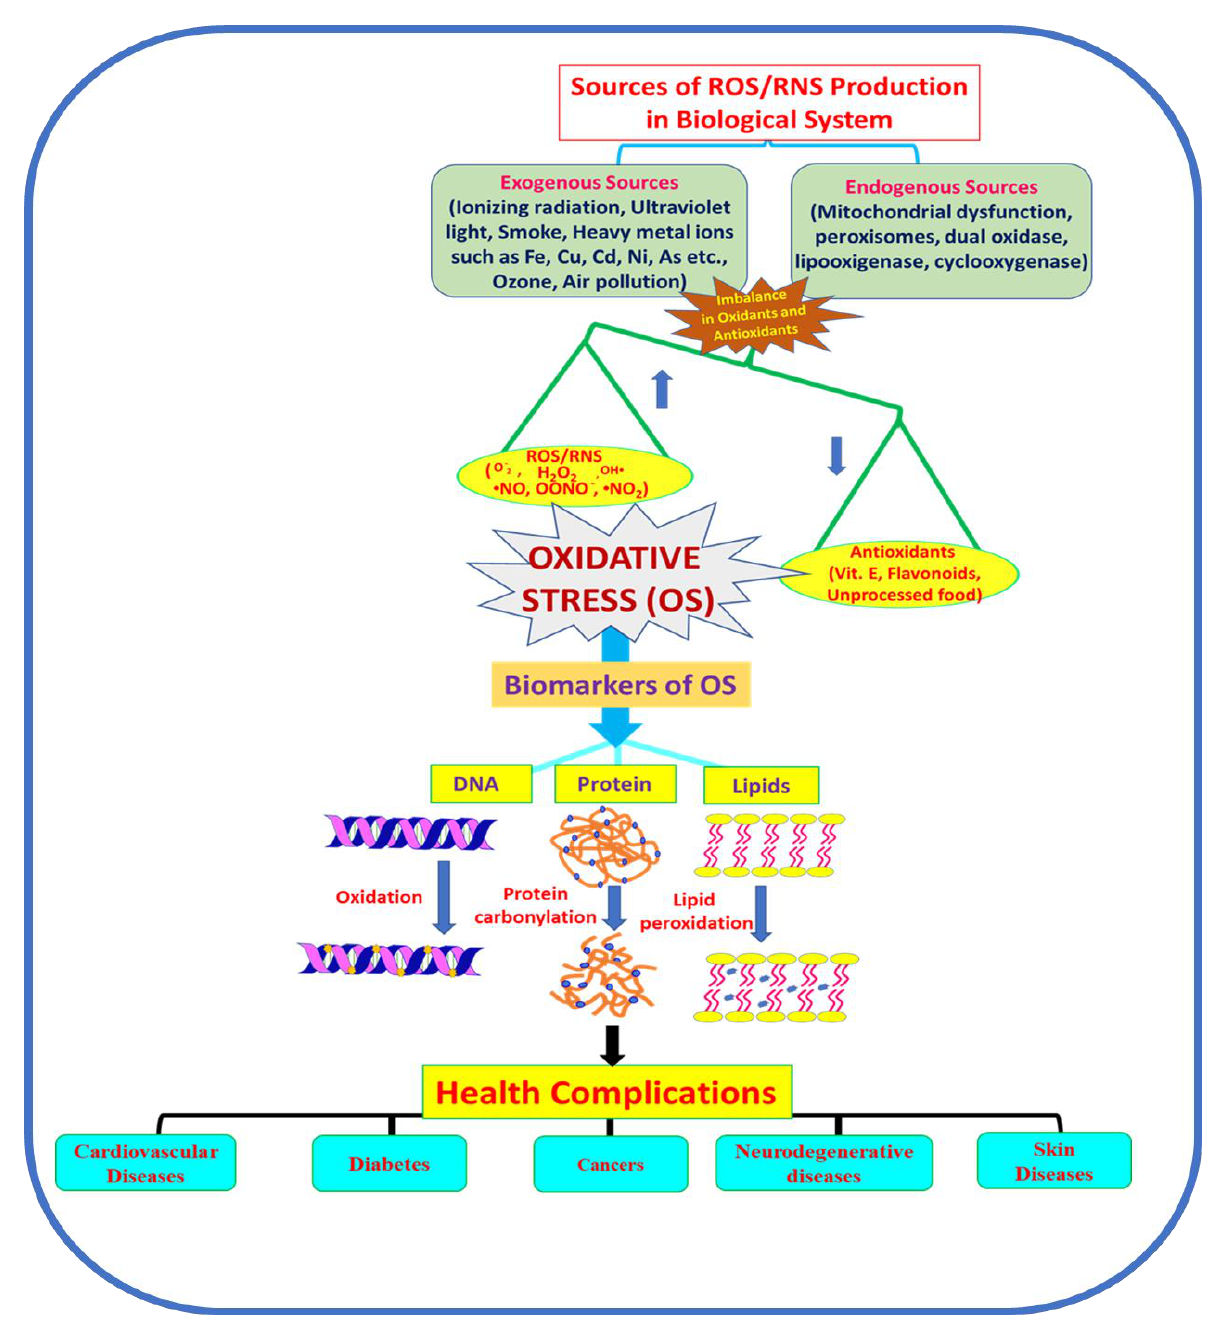
Figure 2. Schematic representation of some sources involved in the production of ROS/RNS, causes of oxidative stress, biomarkers of OS and diseases.